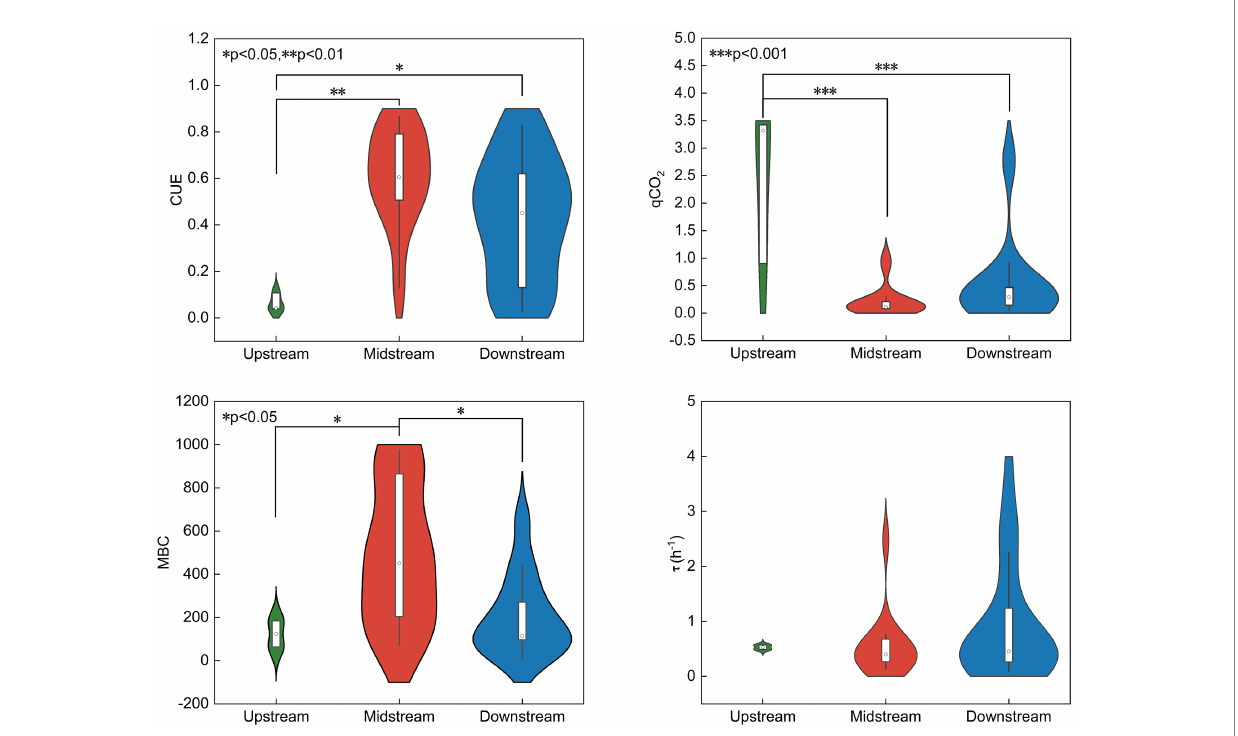
FIGURE 2 Soil carbon metabolism indicators along the different riparian zones (upstream, midstream and downstream) of TGR. CUE, carbon use efficiency; MBC, microbial biomass carbon; qCO 2 , metabolic quotient; τ , microbial biomass turnover time. * p < 0.05, ** p < 0.01, *** p <